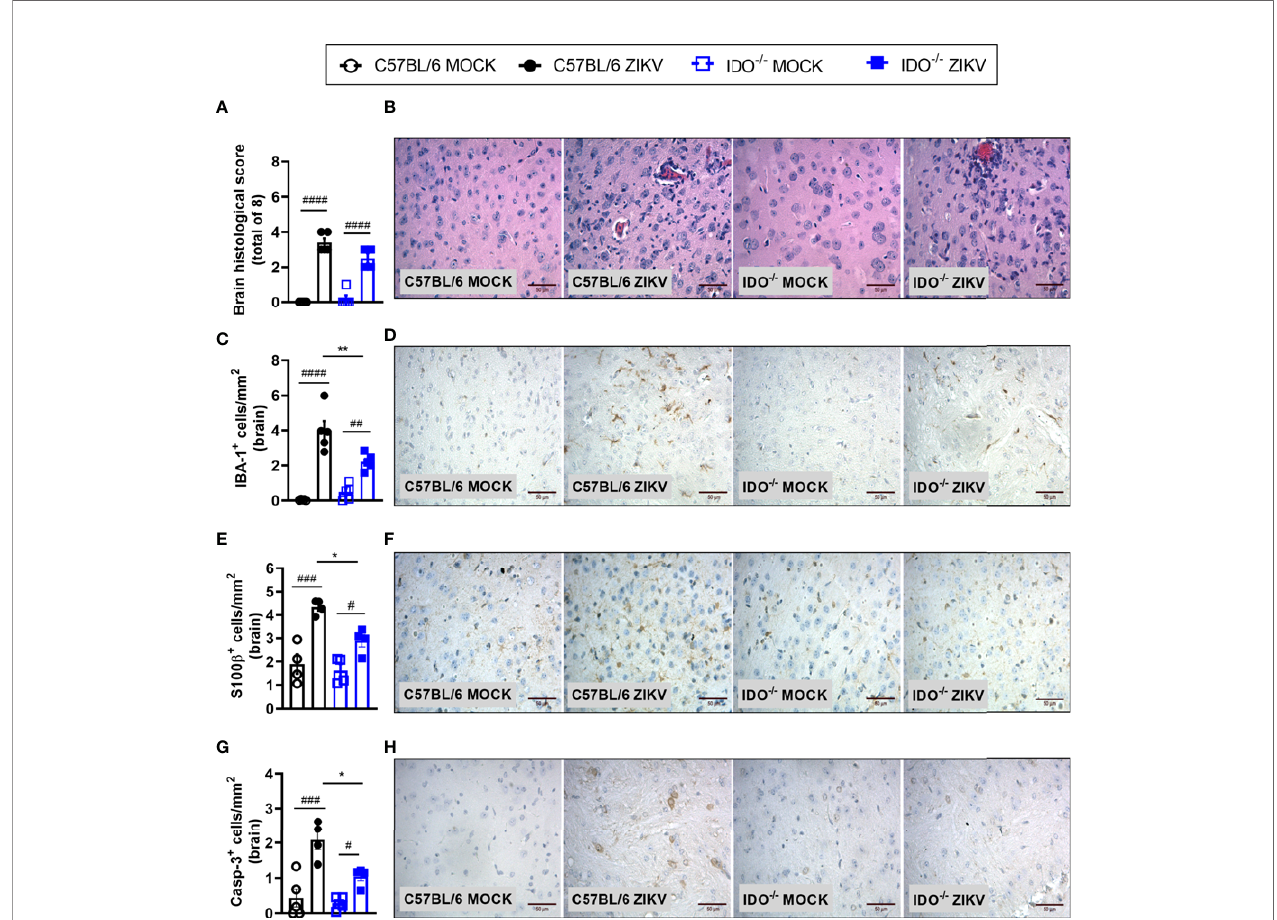
FIGURE 6 | Morphometric analysis of the brain of WT and IDO -/- mice infected by ZIKV. C57BL/6 and IDO-1 -/- were inoculated (intracranial) with 1x10 6 PFU/20 m L of ZIKV. (A) Semiquantitative analysis (histopathological score) after H&E staining of brain sections of ZIKV-infected mice 5 days after infection. (C, E, G) Immunostaining of (C) IBA-1 + , (E) S100- b + and (G) Caspase-3 was performed in the brains of mice. (B, D, F, H) Representative images from brain sections. Results are expressed as mean and error bar indicate the standard error (SEM) and are representative of at least two independent experiments. Statistically signi fi cant differences were assessed by One-way ANOVA plus Tukey ’ s comparisons test (#) for P < 0,05 , (##) for P < 0,01 and (###) for P < 0,001 and (####) for P < 0,0001 when compared to the MOCK group. (*) for P < 0,05 and (**) for P < 0,01 compared to the ZIKV